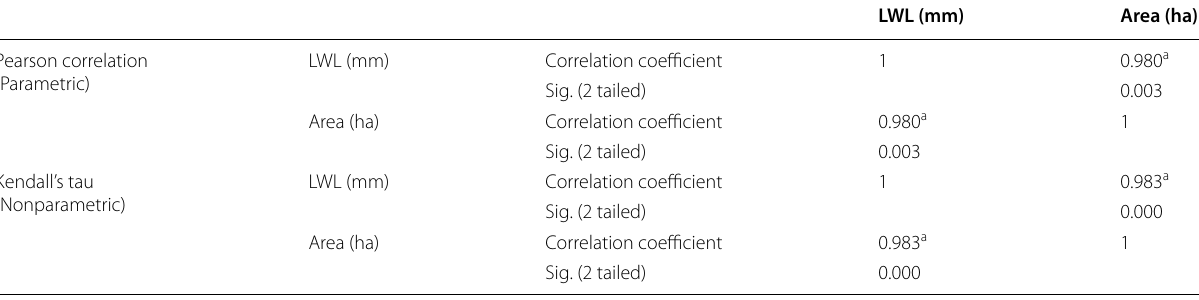
a Correlation is significant at the 0.01 significant levels (2 tailed) Table 8 Lake Hayk water area variations (2005–2011)